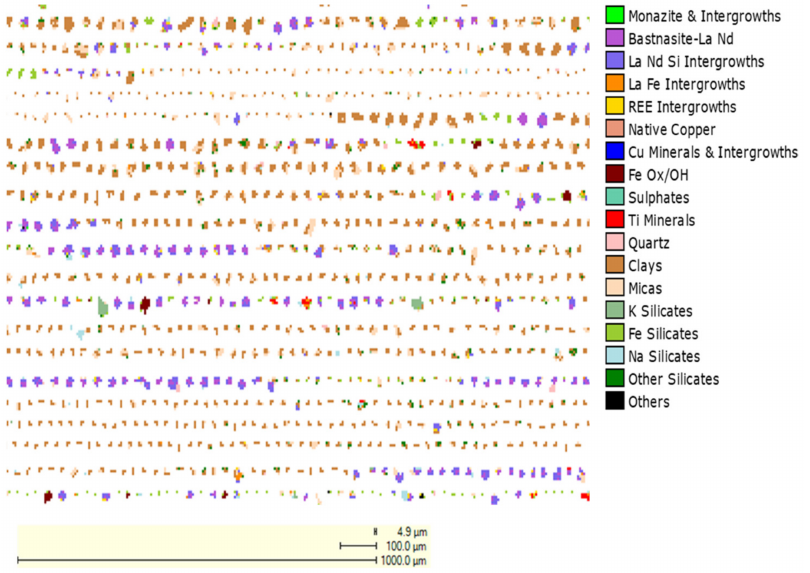
Figure 10. Particle view of the flotation